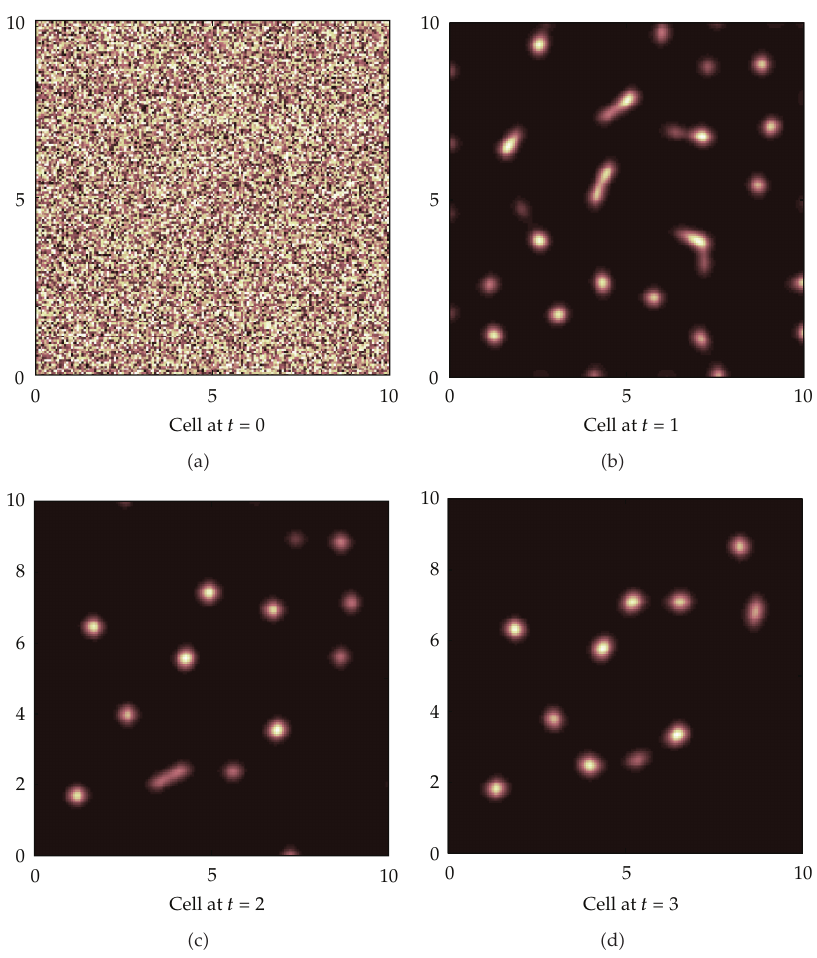
Figure 4: Numerical simulations for bacterial aggregates they exposed to TCA cycle: from left to right, top to bottom. The aggregates are separated into small regions and then cojoin other aggregates. The aggregates become fewer but